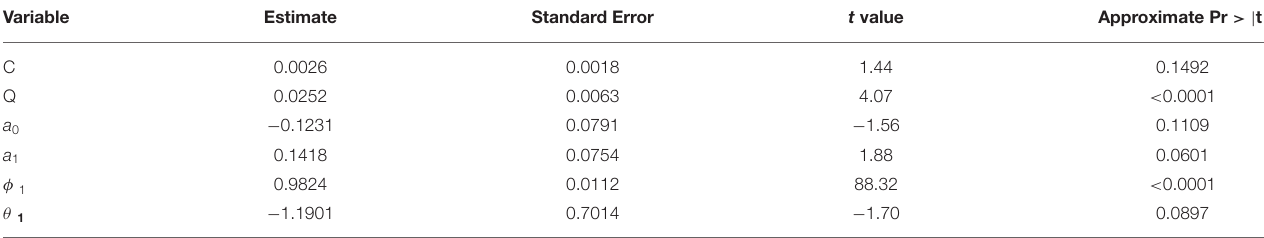
TABLE 9 | Parameter estimation results of model (11) (1).